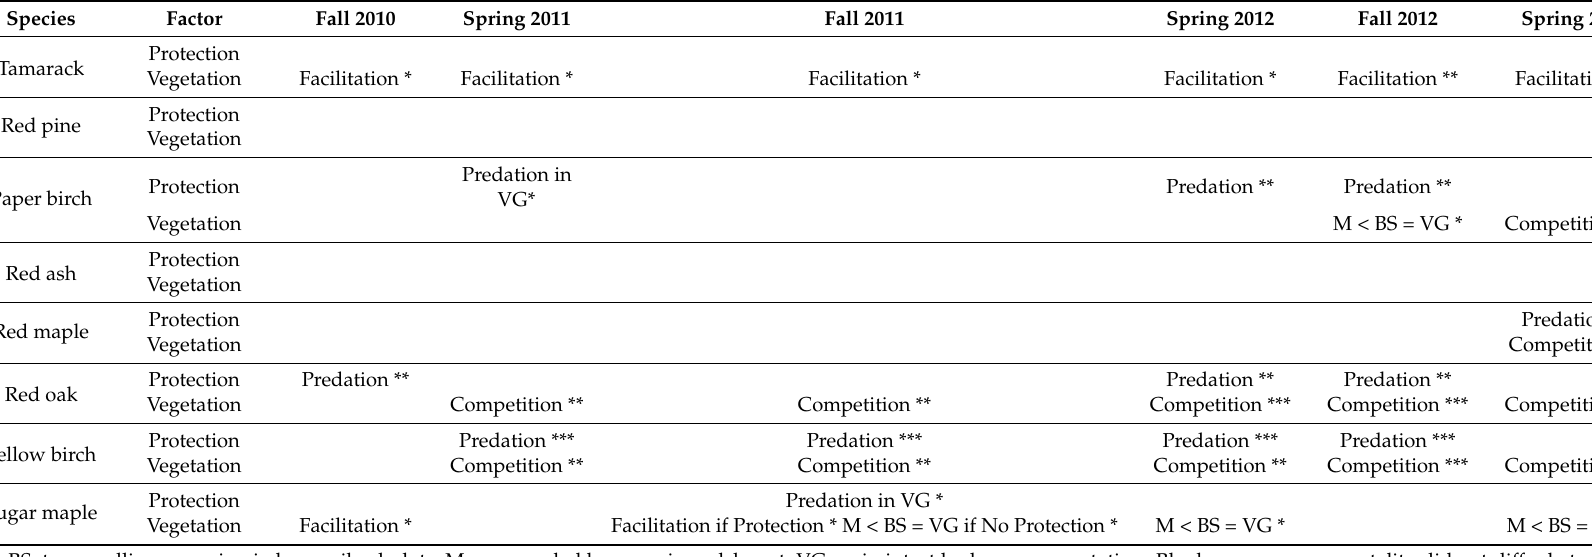
Table 2. Predation, competition, and facilitation effects estimated from the results obtained from the different experimental treatments on tree seedling mortality from fall of 2010 to spring of